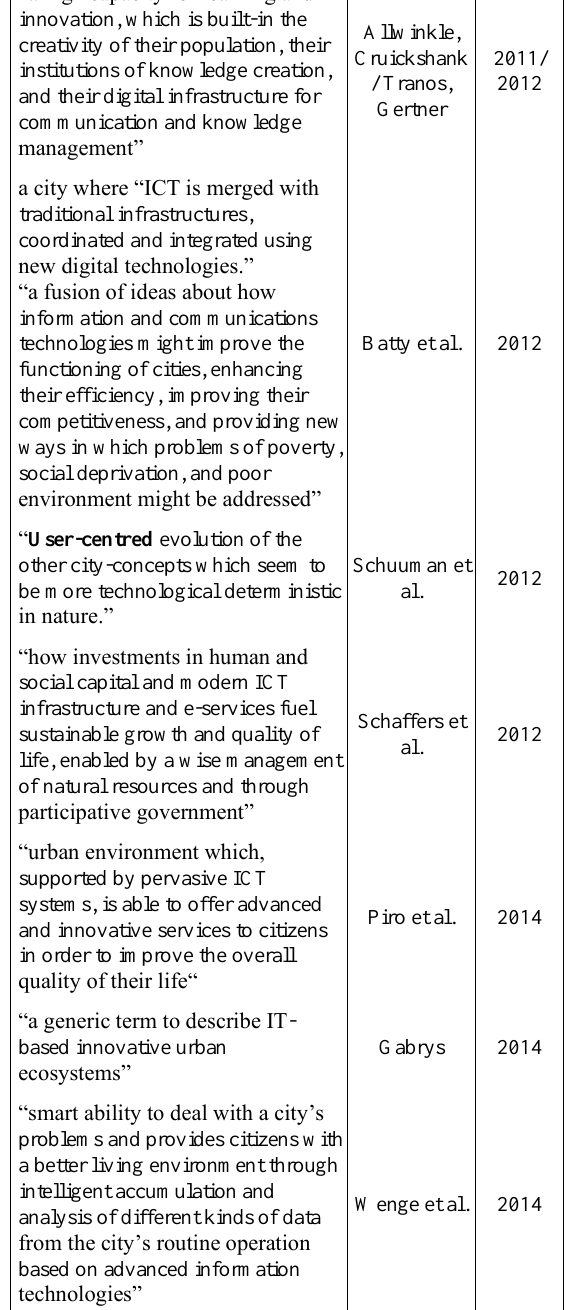
Table 1. The definitions used by experts for the term smart